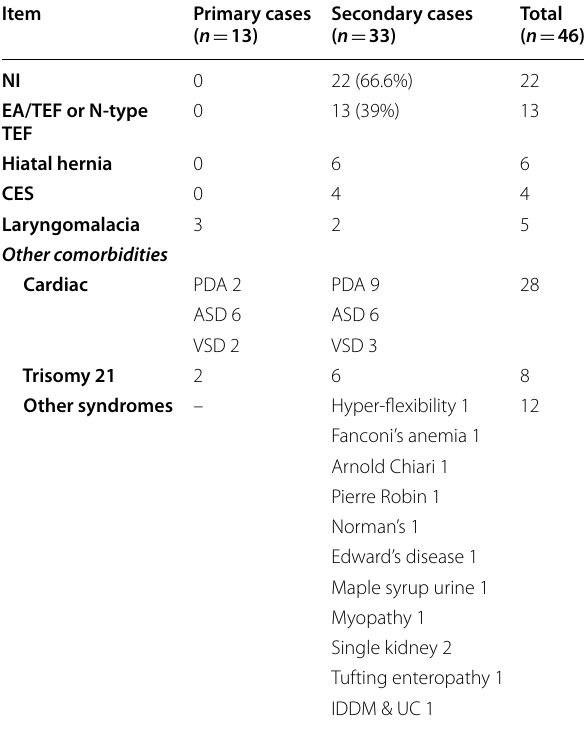
Table 3 Types of patients and associated